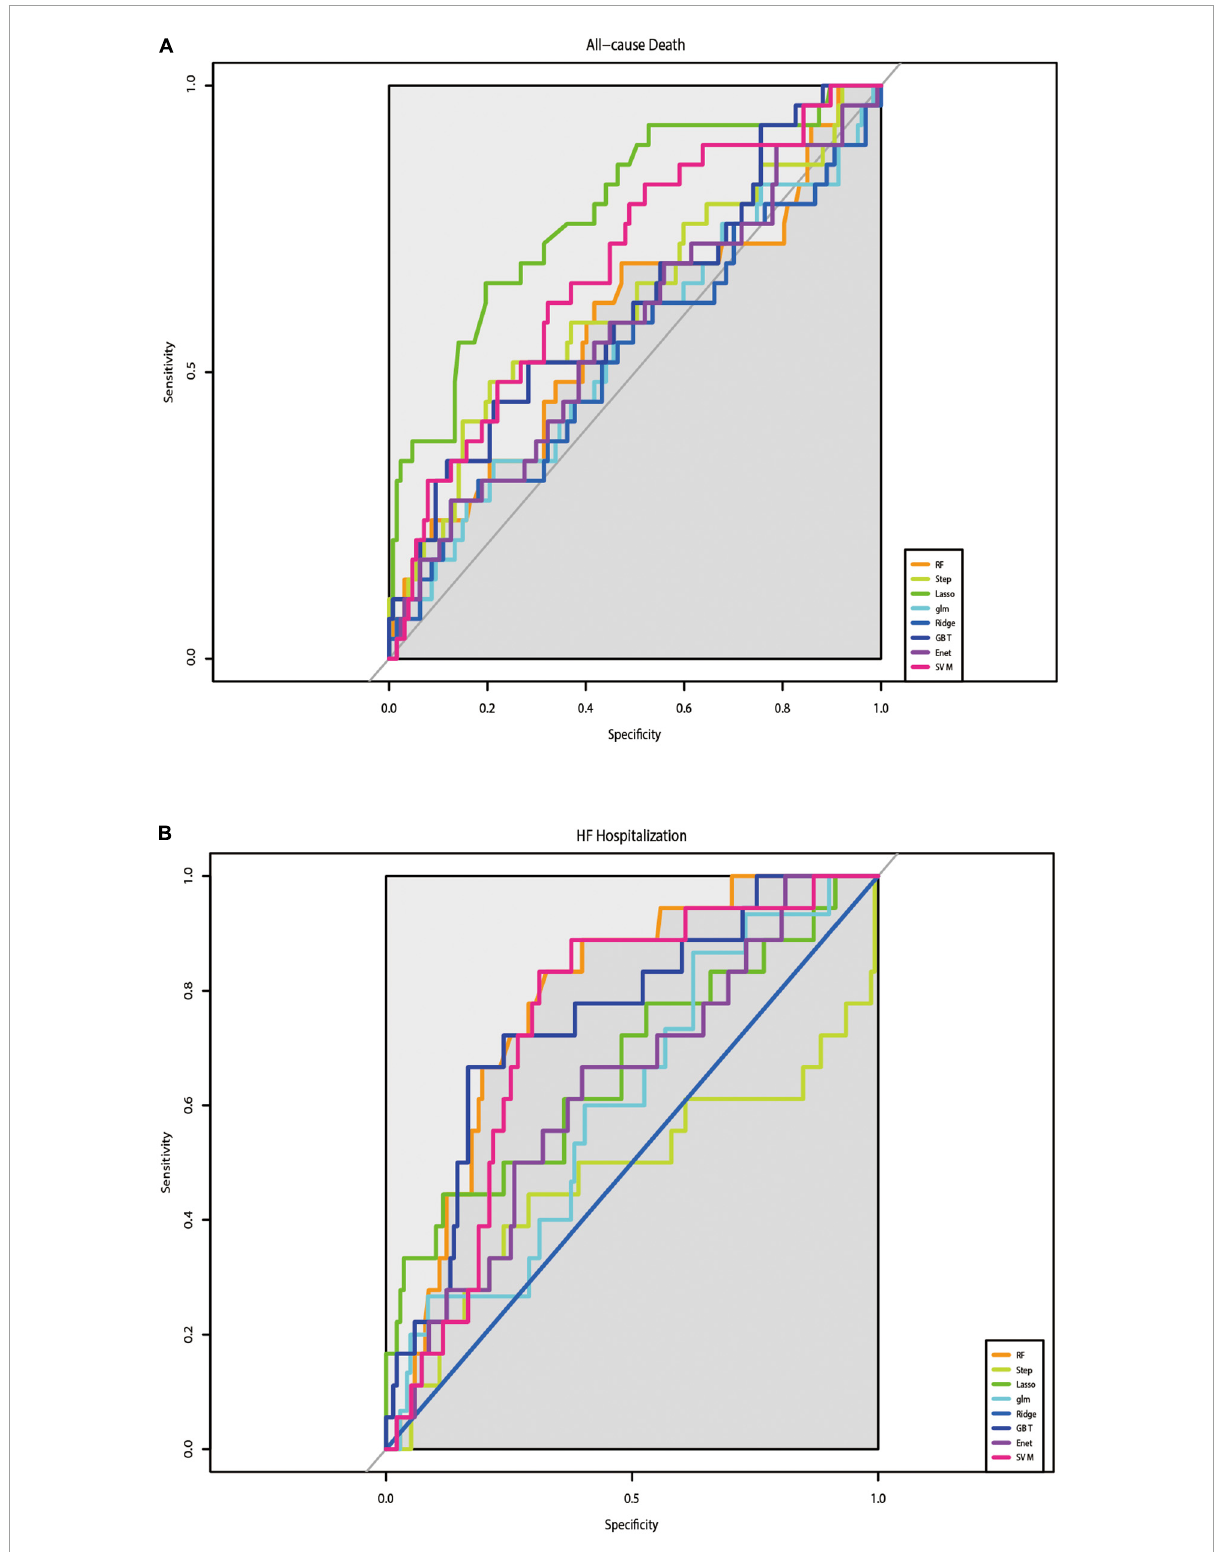
FIGURE2 Results of the discrimination for all-cause mortality and HF-Hospitalization in ROC curves. (A) The performance of eight prediction models for all-cause mortality was assessed by ROC curves. (B) The performance of eight prediction models for re-hospitalize was assessed by ROC curves.